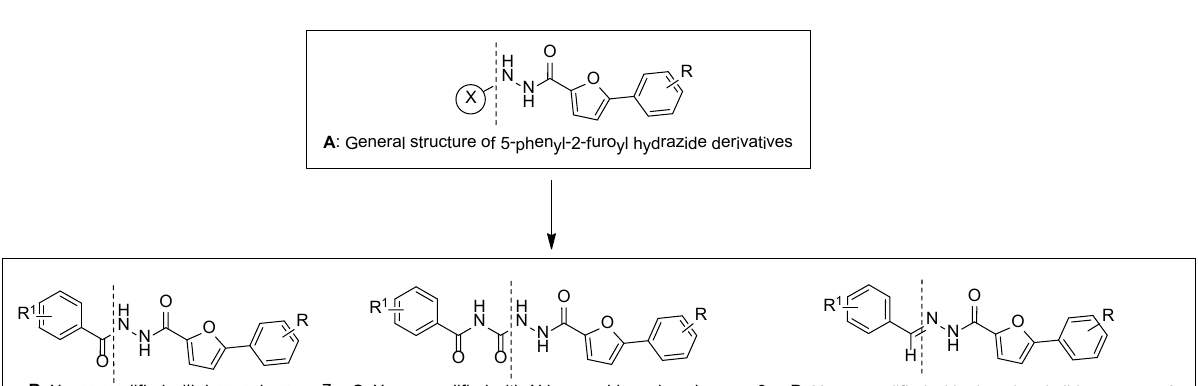
Scheme 1. Designed strategy for title